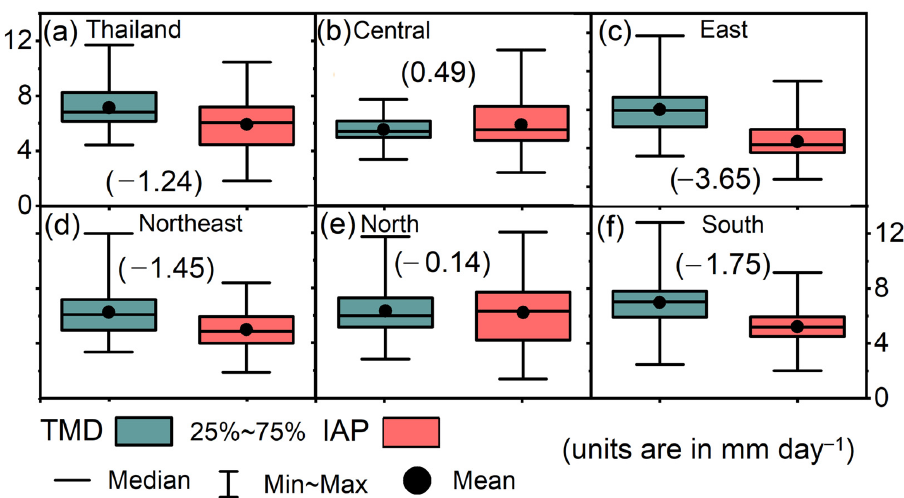
Figure 3. The box–whisker plots show the maximum, minimum, mean, lower quartile, upper quartile, and median of the observed and simulated rainfall over the 32-year period (1981–2012) for ( a ) Thailand, ( b ) Central, ( c ) East, ( d ) Northeast, ( e ) North, and ( f ) South. Numbers in parenthesis present the bias between the mean of the observed and simulated rainfall.